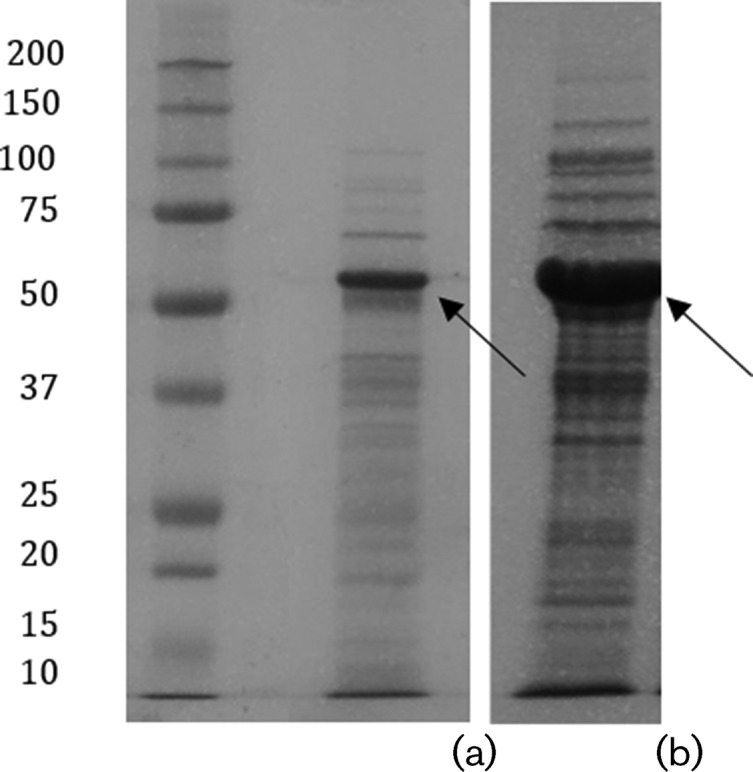
SDS-PAGE analysis of the solubilized inclusion bodies of His6MBPBladSP10-5 (a) and His6MBPBladSub5 (b). Molecular masses of standards are indicated in kDa.